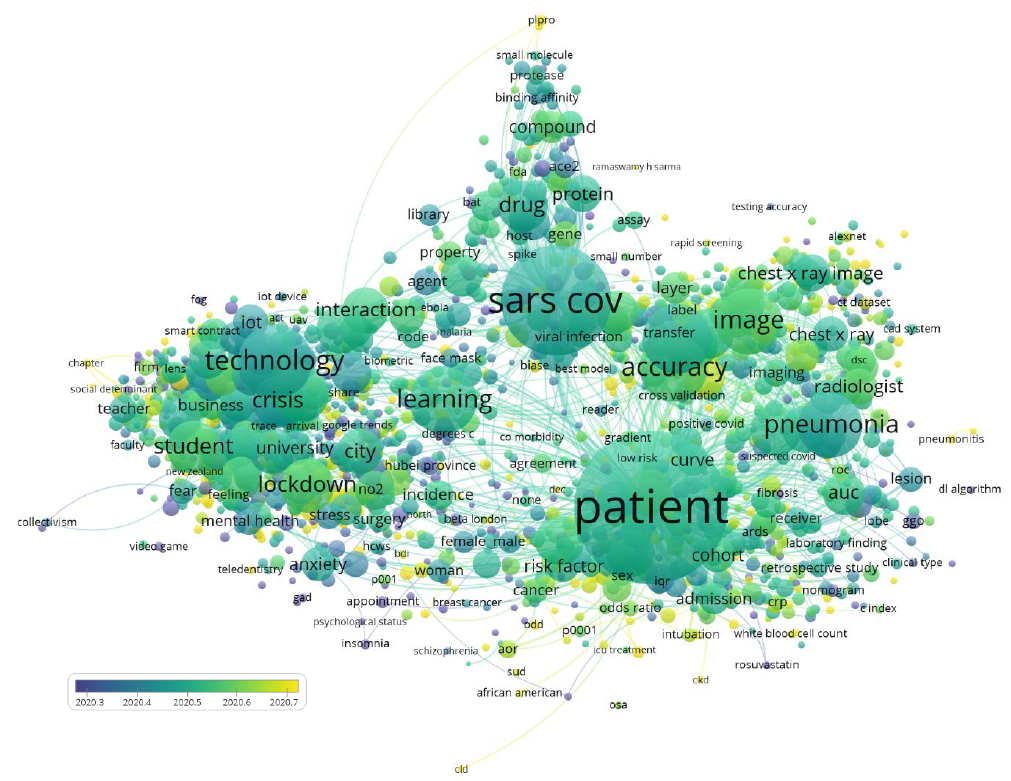
Figure 9. Topic mapping and visualization overlaid with the average year of publication (source WoS).